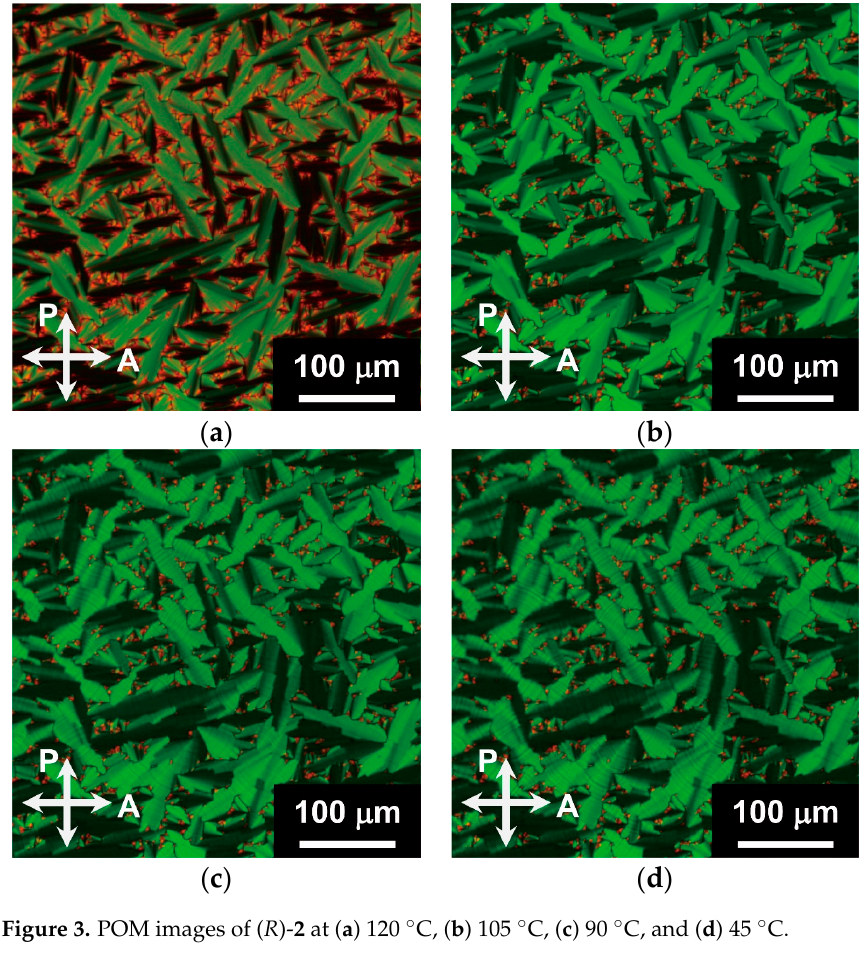
Figure 2. POM images of ( R )- 1 at ( a ) 140 °C, ( b ) 95 °C, and ( c ) 40 °C. The black arrows indicate the border of ITO electrode and glass surface.